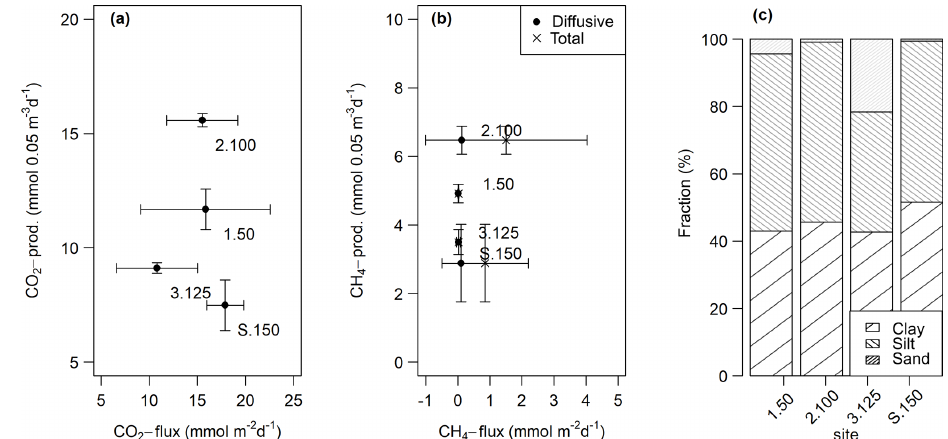
Figure 9. Comparison of fluxes obtained from intact sediment core incubations and potential production rates from the slurry incubations (at 0–5cm sediment depth) for CO 2 (a) and diffusive and total CH 4 (b) . The points are averages – n (slurry incubations) = 3–9, n (CO 2 fluxes) = 9–14, n (CH 4 fluxes) = 11–13. The horizontal and vertical lines are standard deviations. We decided to display production rates from the 0–5cm sediment depth as this depth turned out to be the most important for sediment GHG production (see Sects. 3.1.2 and 4.1.1). (c) Relative grain size distribution in intact sediment core